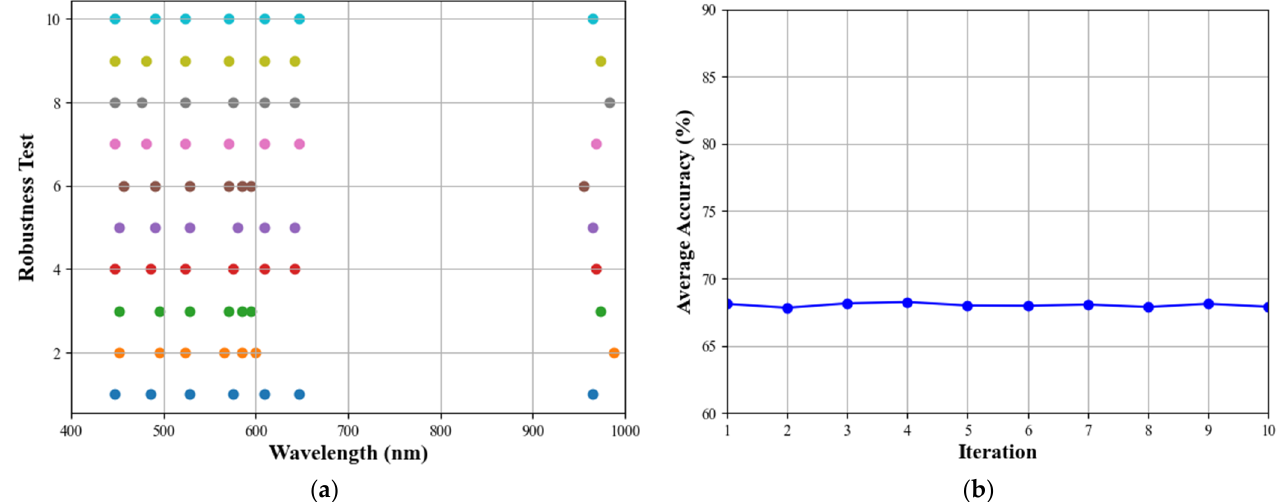
Figure 6. Results of the wavelength selection robustness study. ( a ) Scatter plot showing selected wavelengths for 10 iterations of the k = 7 VNIR study. ( b ) Plot of final accuracies for each of the 10 iterations.